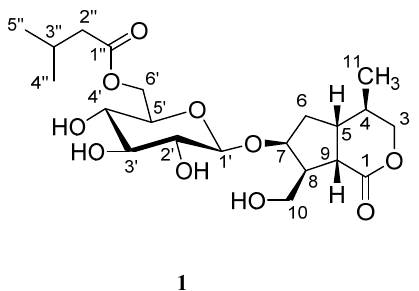
Figure 1. Structures of compounds 1 and 2.